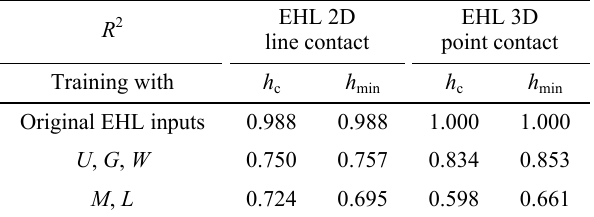
and the previously employed hyperbolic tangent function led to high R 2 values beyond 0.99, while the linear identity function resulted in a slightly downgraded prediction quality.